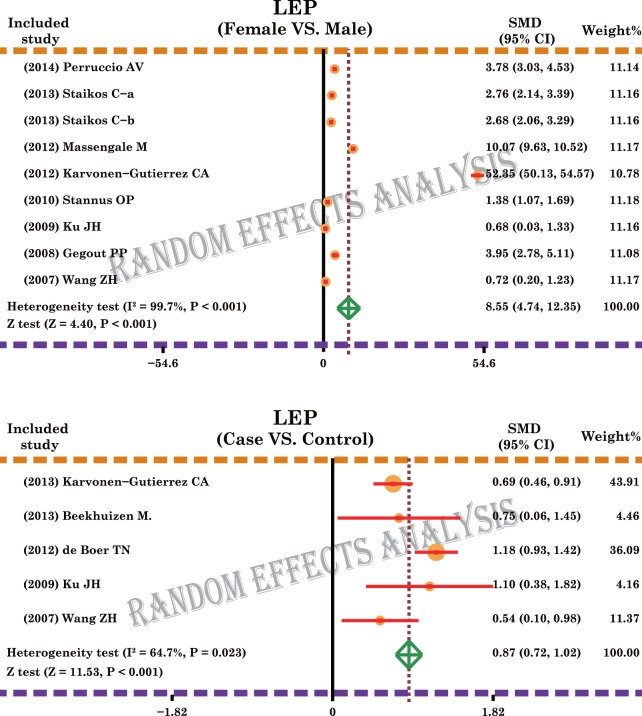
Forest plot for the relationships between leptin expression levels and the development of osteoarthritis.